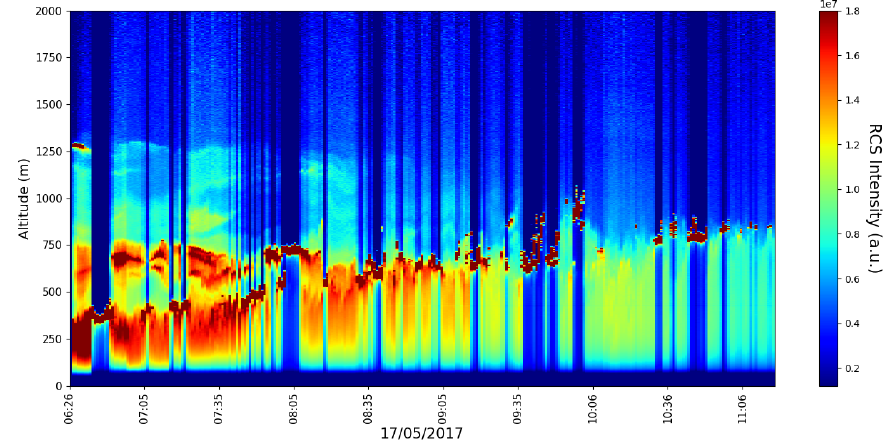
Figure 9. RCS profile timeseries, profiling rate 1/min, 17 April 2017.